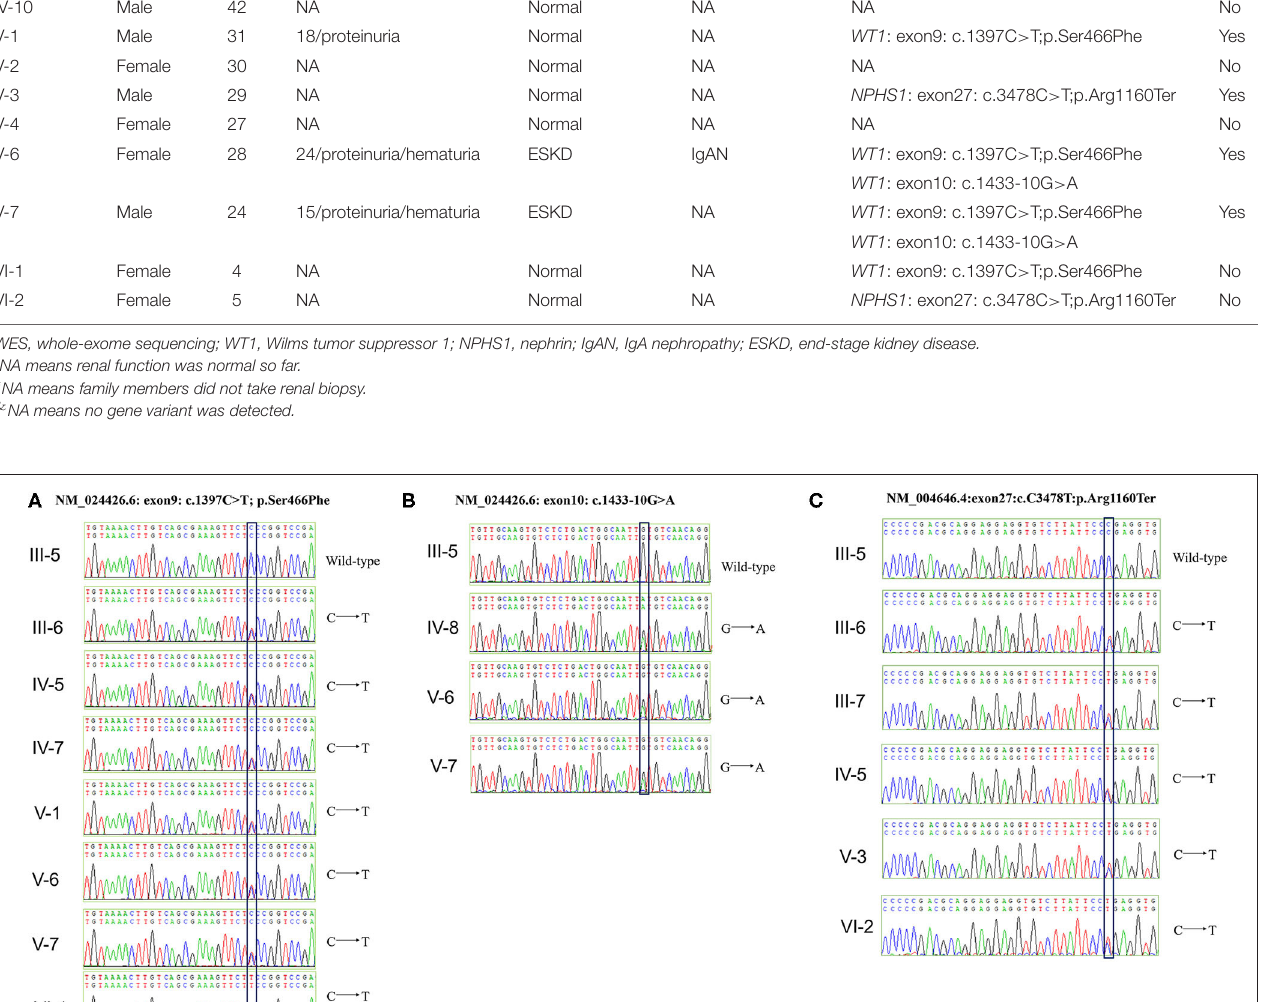
Frontiers in Medicine |